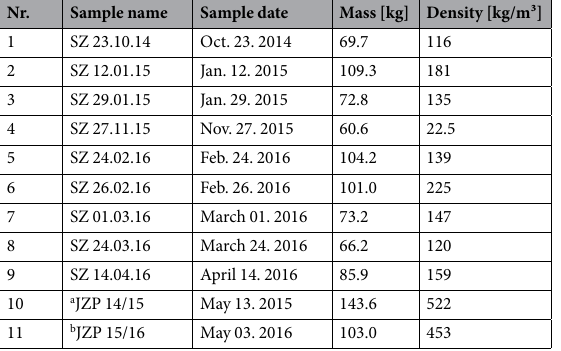
Table 2. Sampling date, amount and density of collected snow. SZ: fresh snowfall, a JZP: snow naturally accumulated in the snow season of 2014–2015 and b